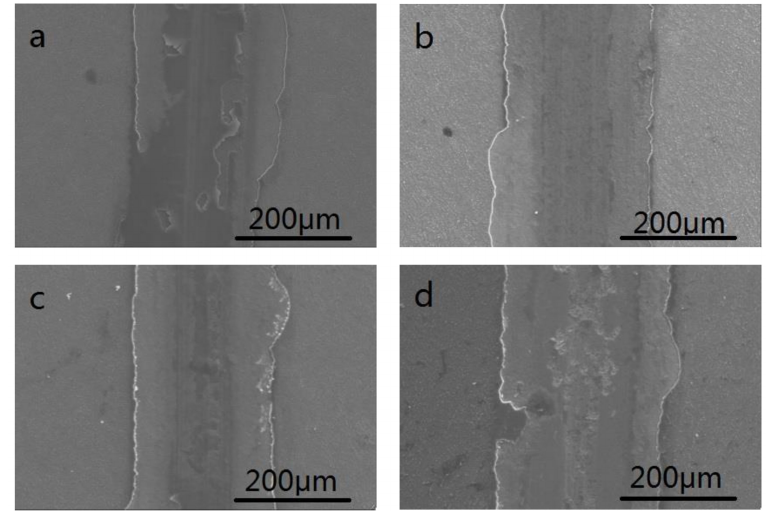
Figure 7. SEM image of the wear track morphology in different sections of thermally oxidized sample